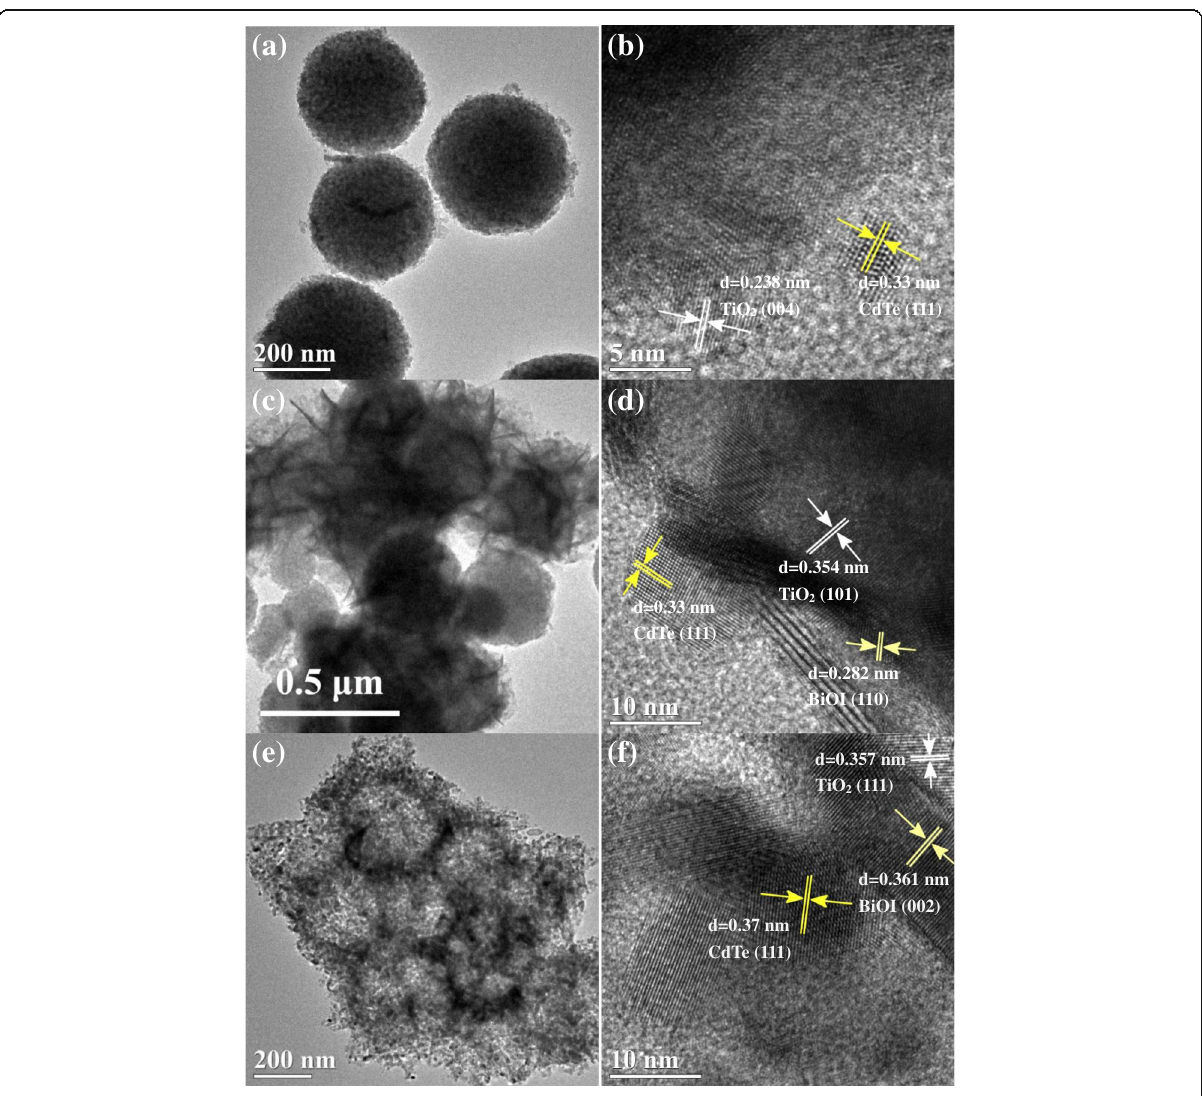
Fig. 3 TEM images of a – b TiO 2 (S)/CdTe, c – d TiO 2 (S)/CdTe/BiOI, and e – f TiO 2